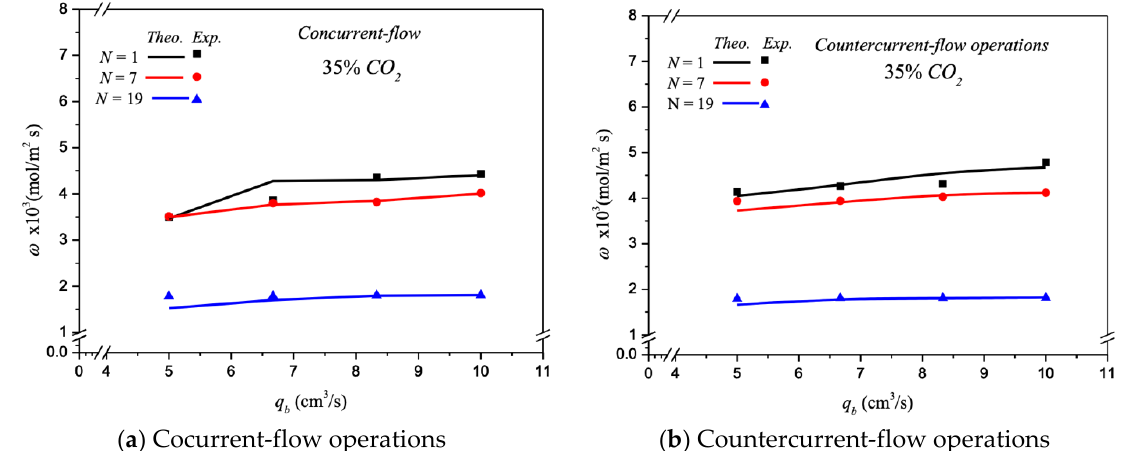
Figure 10. Effects of MEA flow rate and various fiber cells on CO 2 absorption flux.